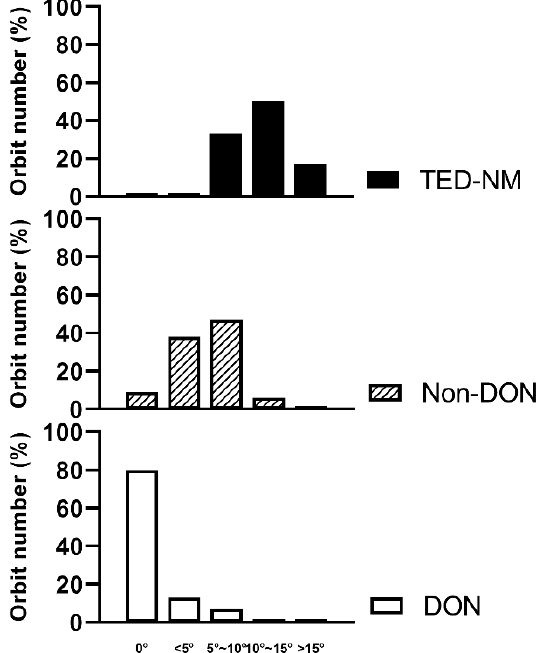
Figure 6. Population distribution of the angle between the medial rectus and optic nerve.